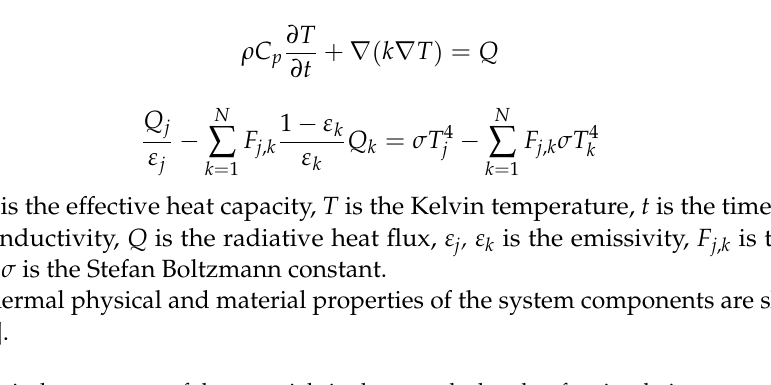
Table 1. Physical parameters of the materials in the growth chamber for